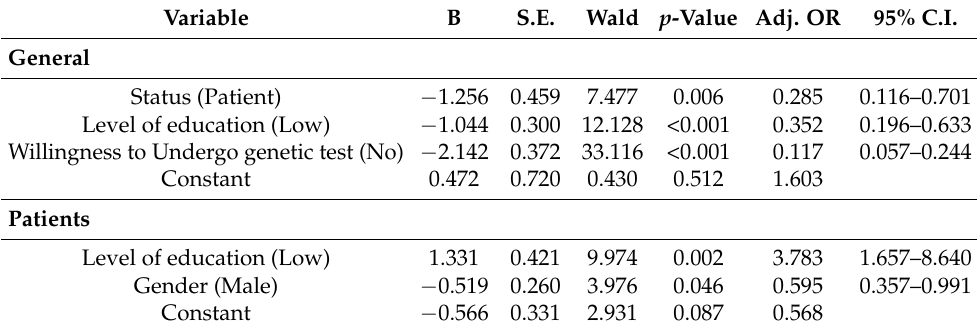
Table 4. Multiple logistic regression for factors influencing WTP for cancer genetic